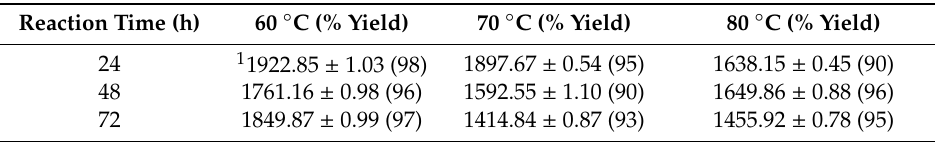
Table 1. M w and yields of the copolymerization reaction at different temperatures.